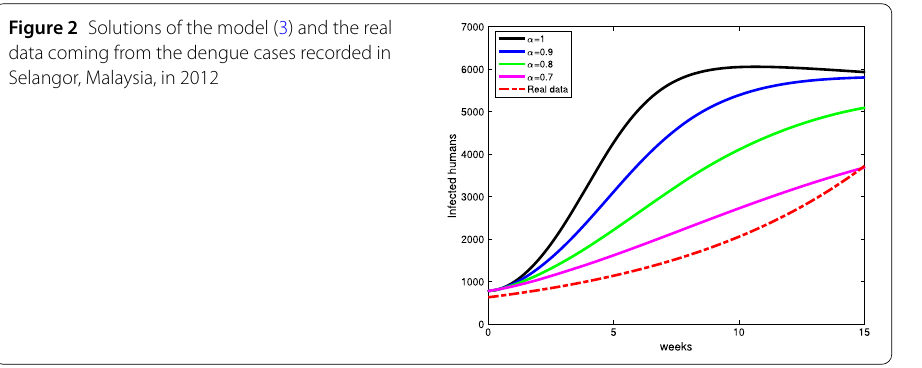
Figure 2 Solutions of the model (3) and the real data coming from the dengue cases recorded in Selangor, Malaysia, in